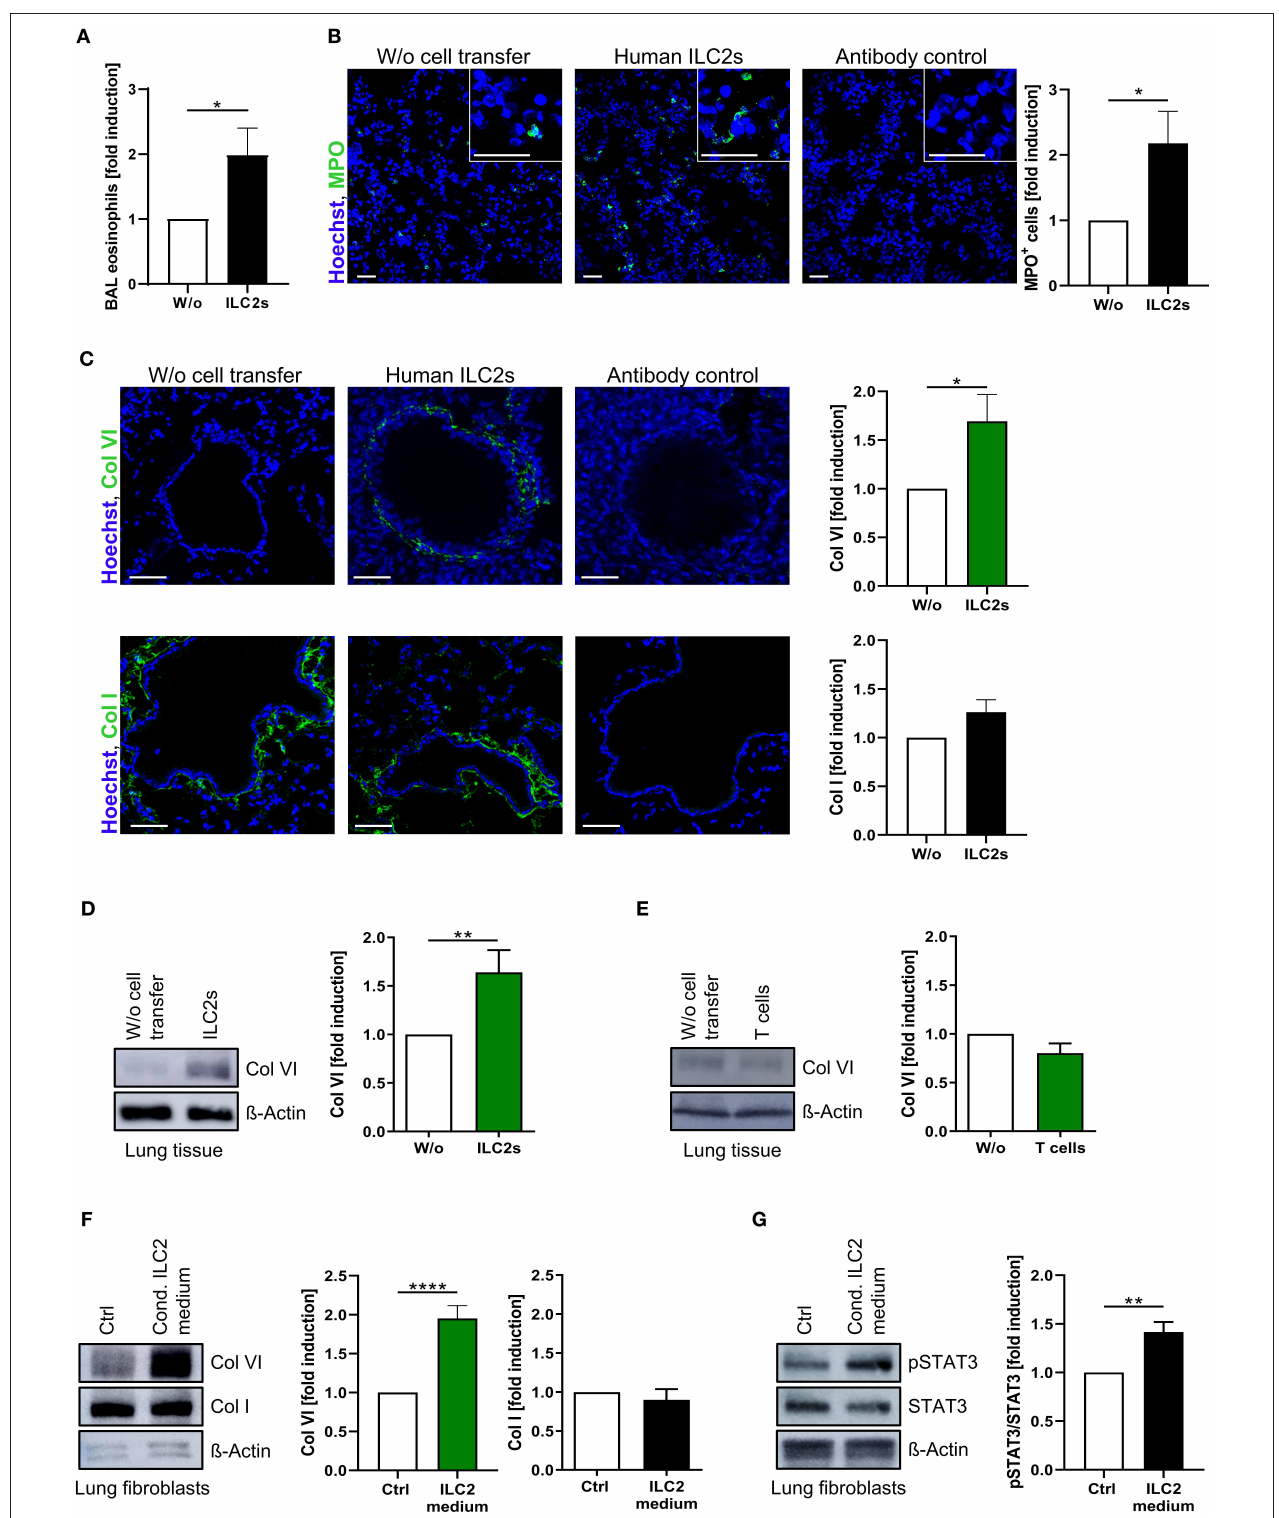
FIGURE 4 | Induction of pulmonary Col VI expression by pb-derived ILC2s in vivo and in vitro . (A) Relative induction of murine BAL eosinophils (flow cytometrically determined as CD11c neg SiglecF + granulocytes) after i.v. injection of expanded human ILC2s in papain-treated mice (ctrl and CF ILC2s pooled, n = 13–21). (B)